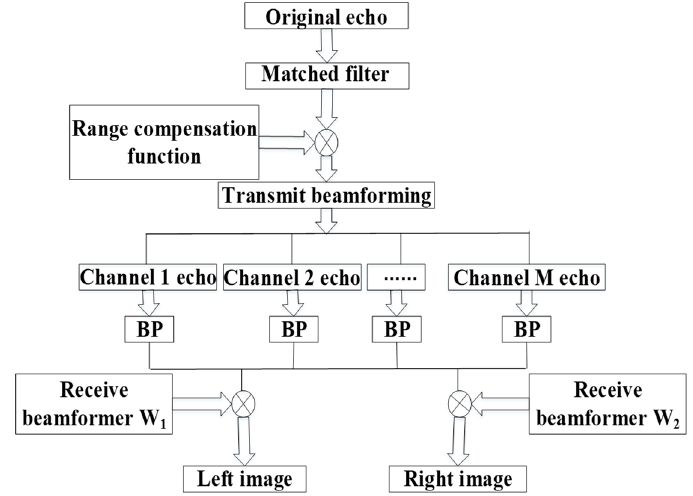
Figure 5. Processing flow chart of the forward-looking FDA-SAR. Note: BP, back projection.